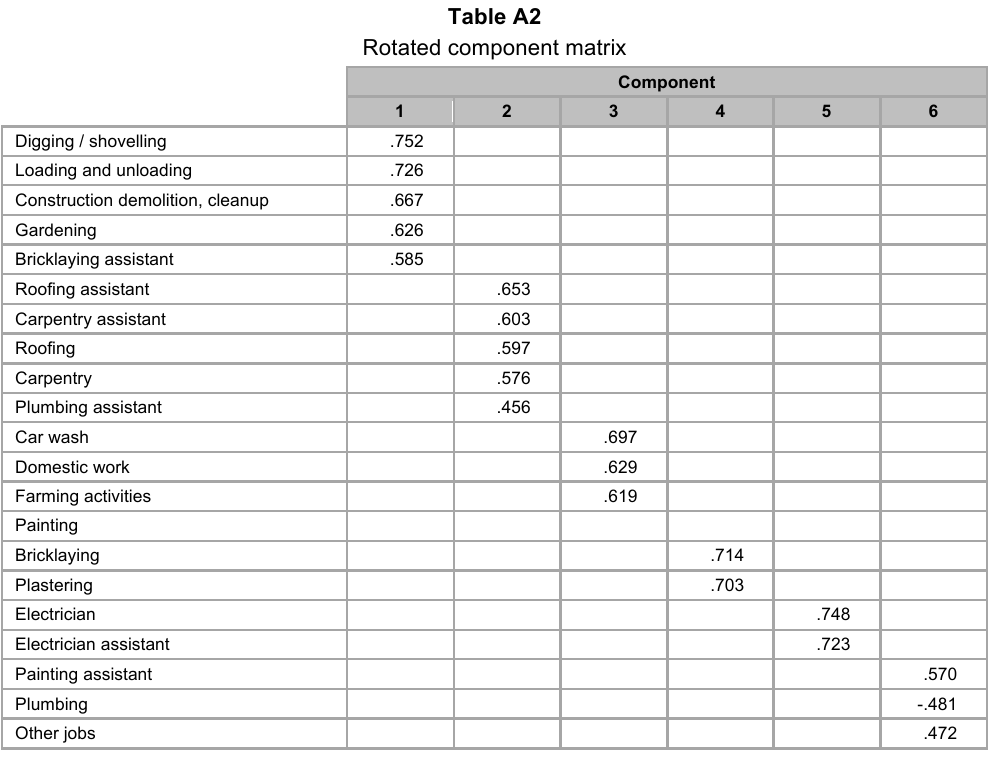
Rotated component matrix